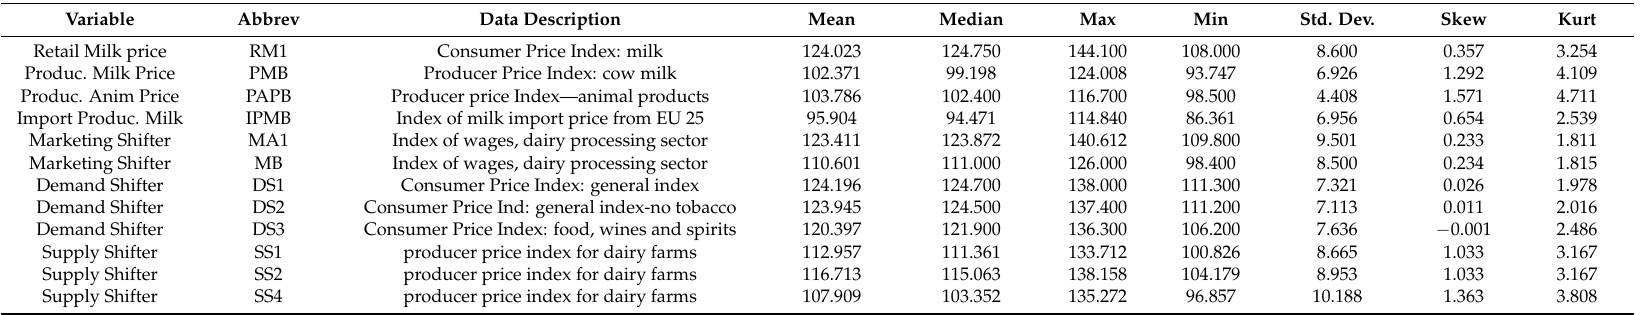
Table A2. Variables included in dataset B and descriptive statistics (common sample January 2000–October 2008, 106